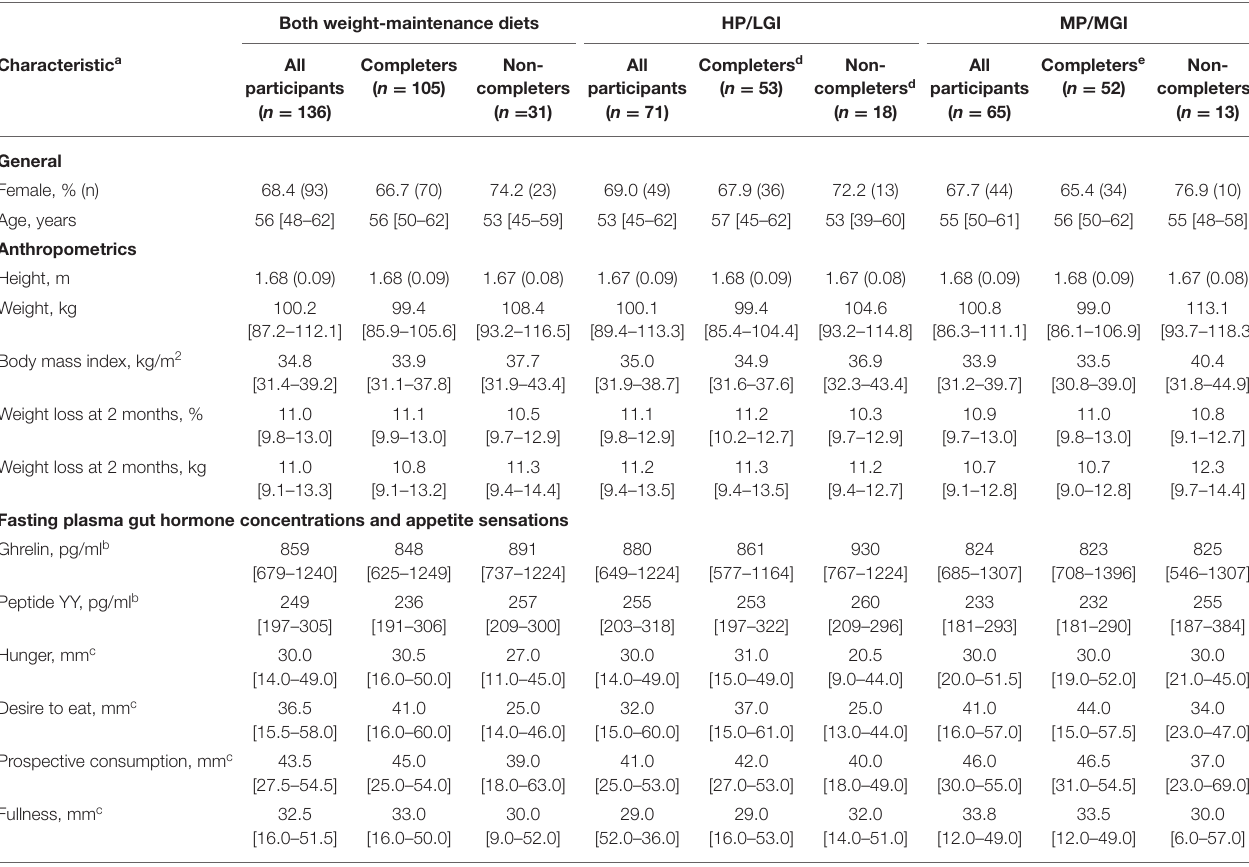
TABLE 1 | Characteristics before weight loss of all participants that completed the 2-month weight-reducing diet and lost ≥ 8% of their initial body weight, subdivided into those who completed or did not complete the subsequent 34-month weight-maintenance diet to which they were randomized [either a higher protein/low GI (HP/LGI) diet or a moderate protein/moderate GI (MP/MGI) diet].